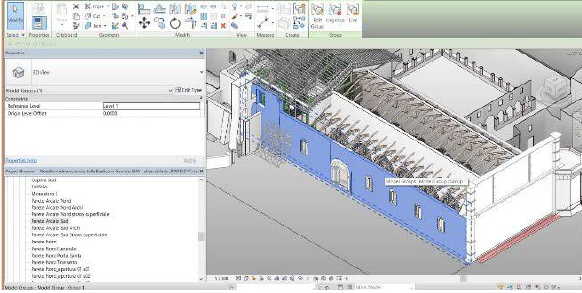
Figure 12. NURBS based BIM modeling (Brumana et al,